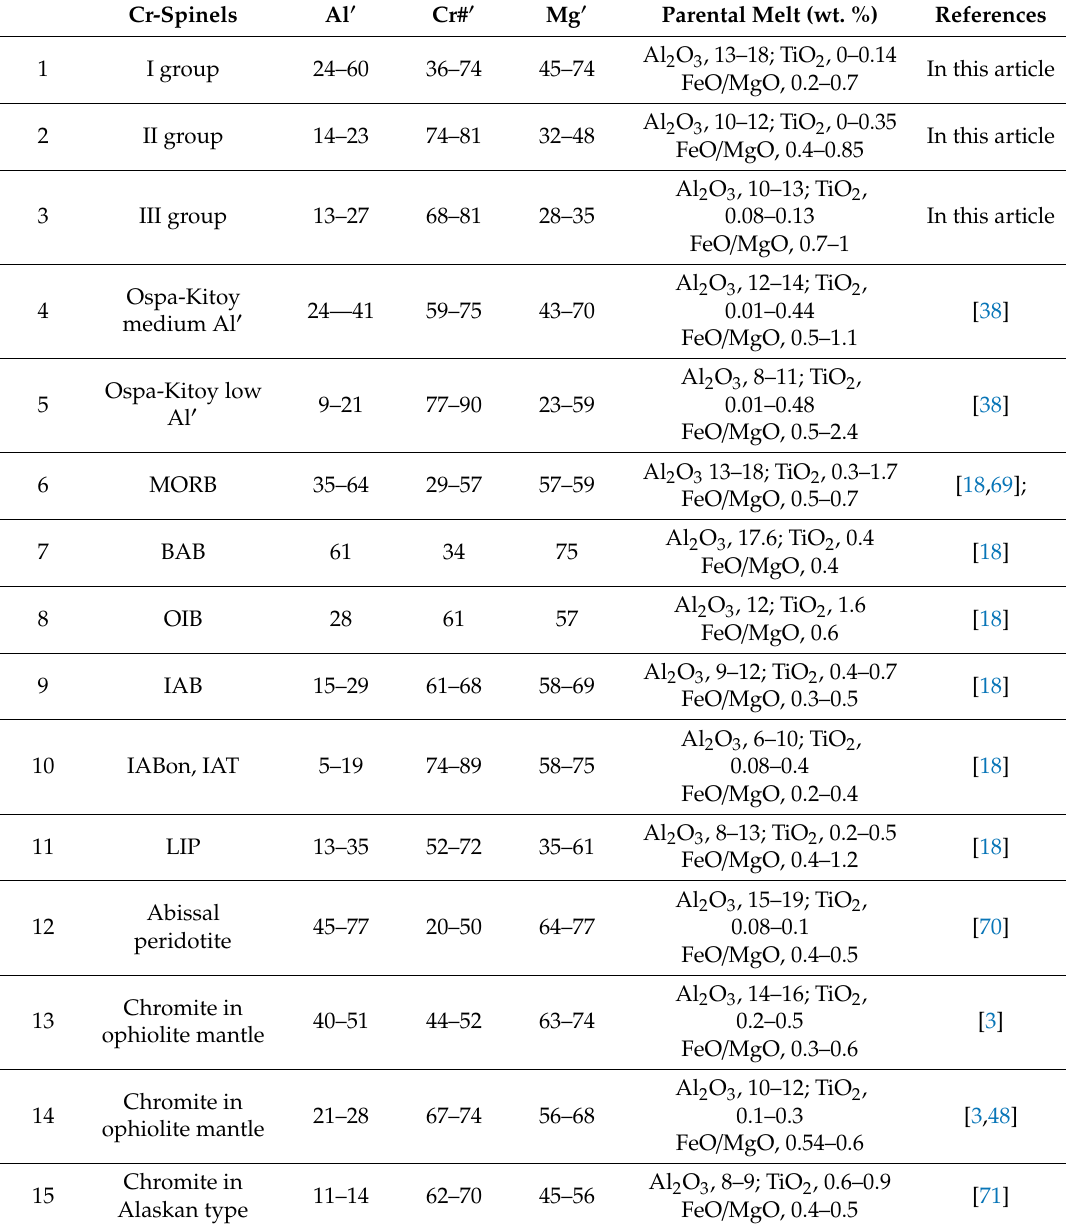
Table 6. Calculated parental melt composition of chrome